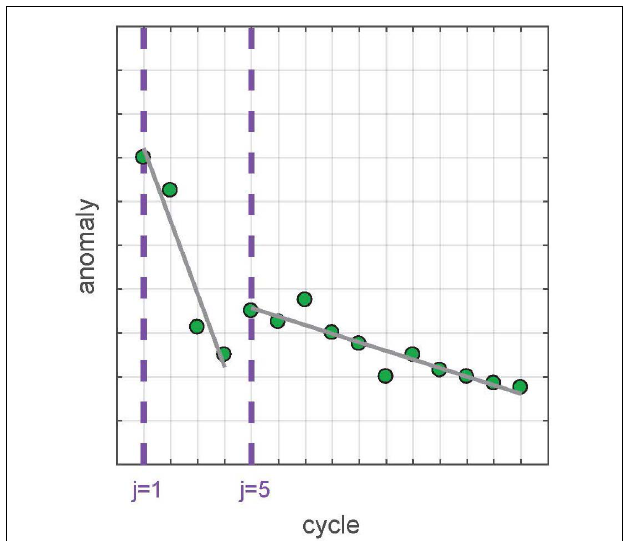
FIGURE 7 | Qualitative schematic showing the adjustment model of a theoretical sensor anomaly series. The two series breakpoints, identified in purple, occur at cycles 1 and 5. Gray lines represent the least-squares fit (adjustment model) to the elements (green dots) within each segment.